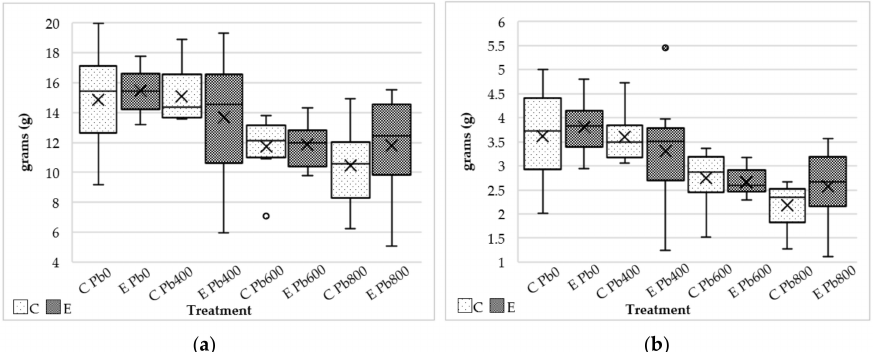
Figure 5. Foliar biomass measurement of fresh ( a ) and dry weight ( b ) of Festuca arundinacea with endophytes treatment ( E ) were compared with the control treatment ( C ) at increasing concentrations of lead in the soil.